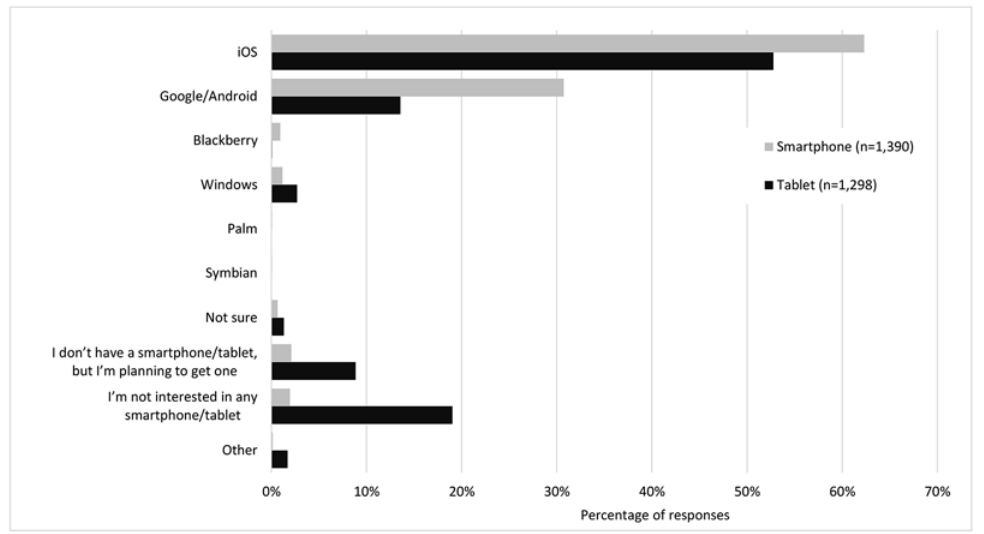
Figure 1 Operating systems of smartphones and